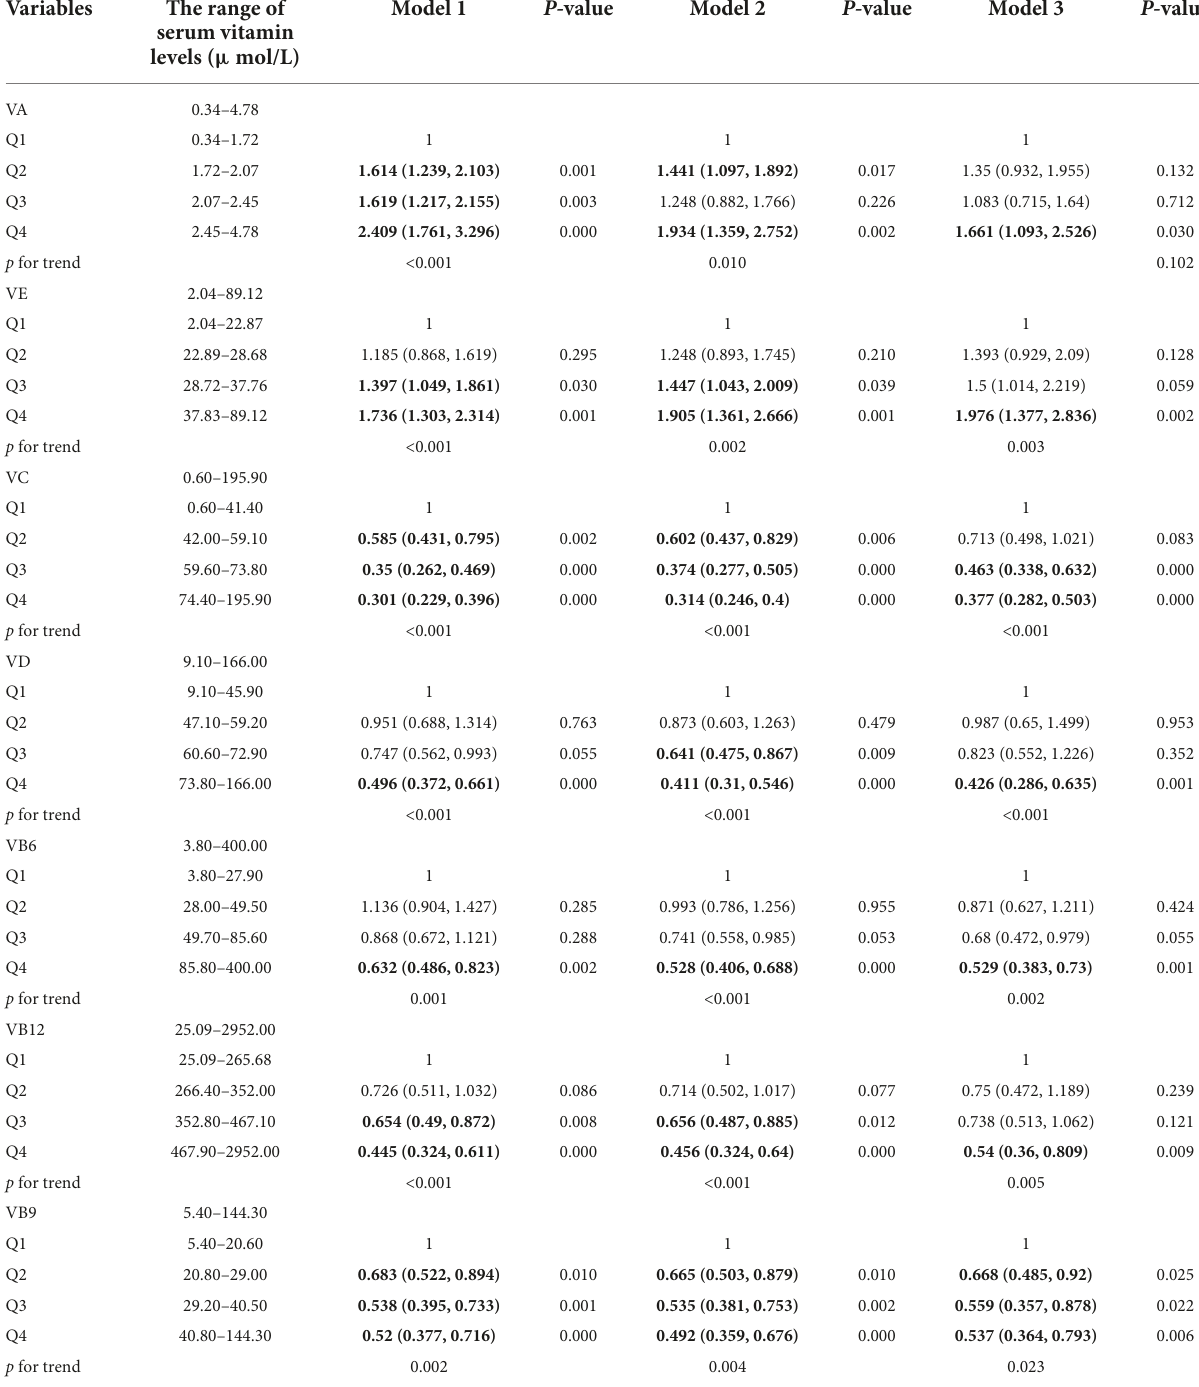
TABLE 3 Multi-variate adjusted odds ratios (95% CIs) of risks of NAFLD in relation to serum vitamins levels among participants in NHANES